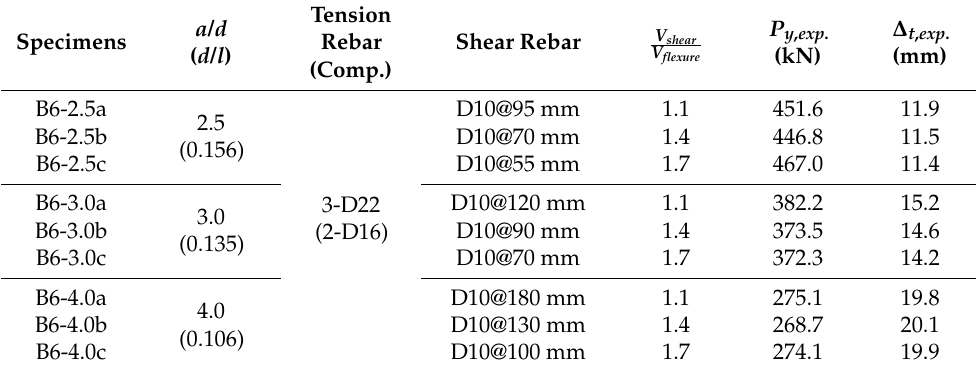
Table 1. Details of Specimens and Experimental Results at Flexural Yield [8,9].